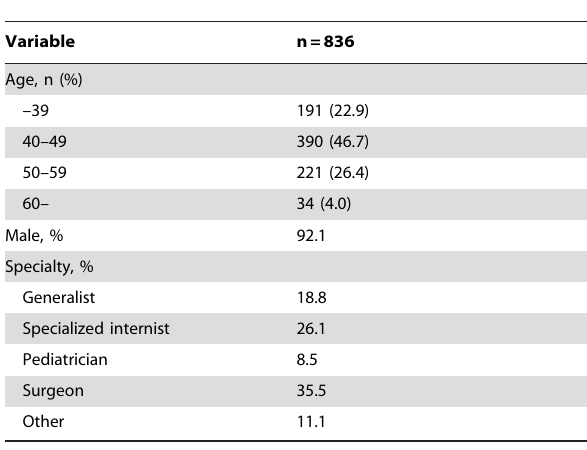
Table 1. Participating physicians’ characteristics, 2009.